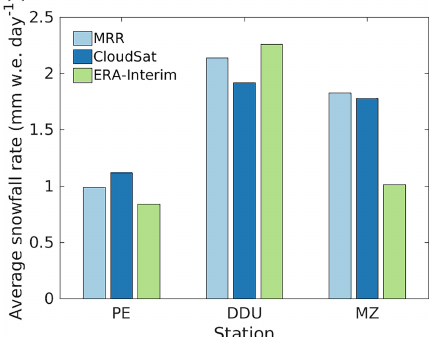
Figure 8. Daily average snowfall amounts (mmw.e.day − 1 ) for the concurrent periods displayed in Fig. 2 for the Princess Elis- abeth (PE), Dumont D’Urville (DDU) and Mario Zucchelli (MZ) stations. CloudSat snowfall amounts are derived for the grid speci- fied by Palerme et al.